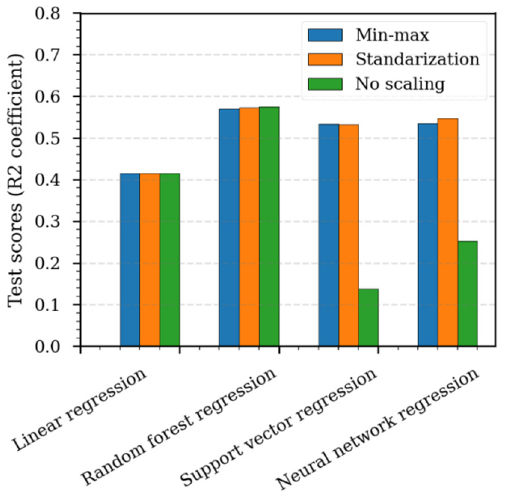
Figure 9. Effect of data scaling on the test score of three machine learning algorithms.